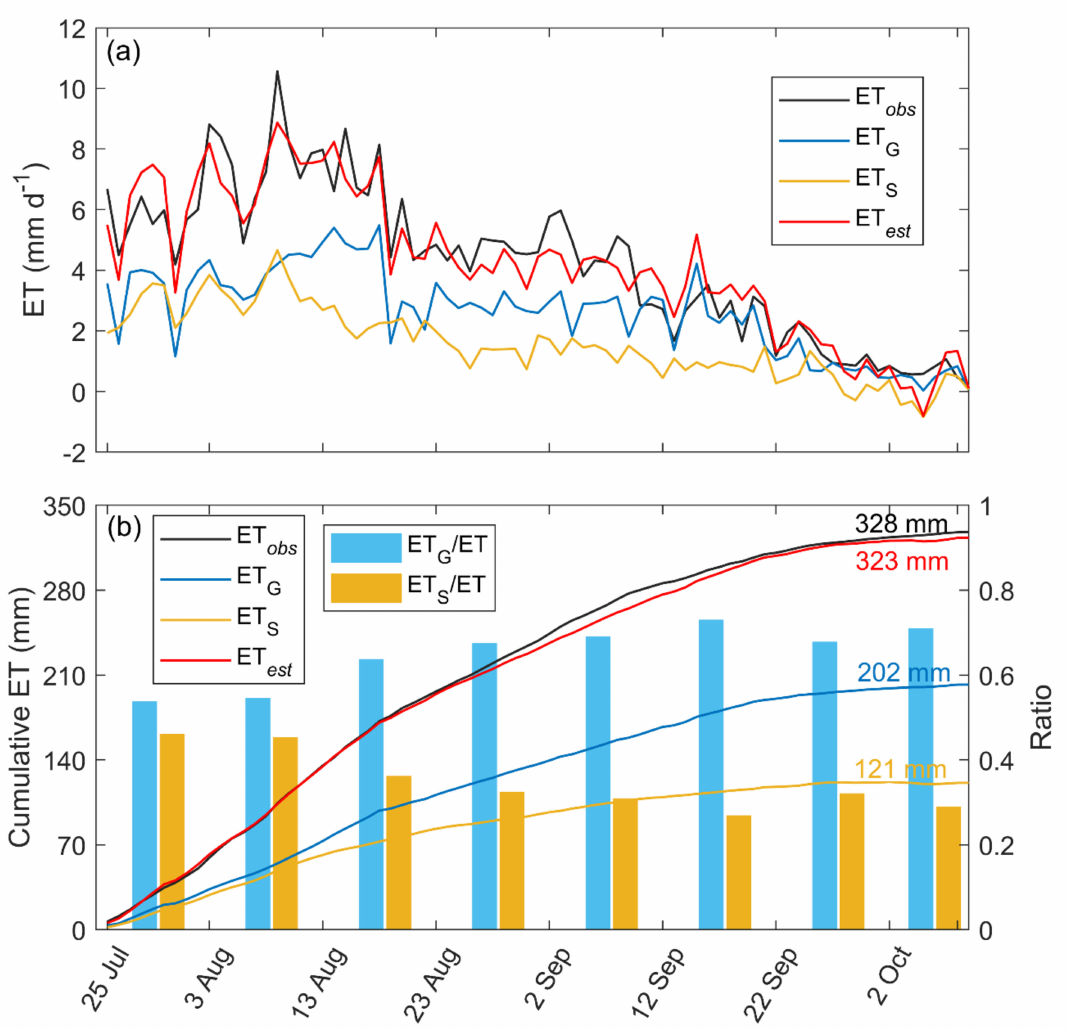
Figure 8. Seasonal variations in ( a ) measured and estimated daily ET, as well as the different components of ET (i.e., ETS and ETG); ( b ) cumulative ET and its different components (left axis) and the ratios of ETG/ET and ETs/ET at 10 day intervals (right axis) during the whole study